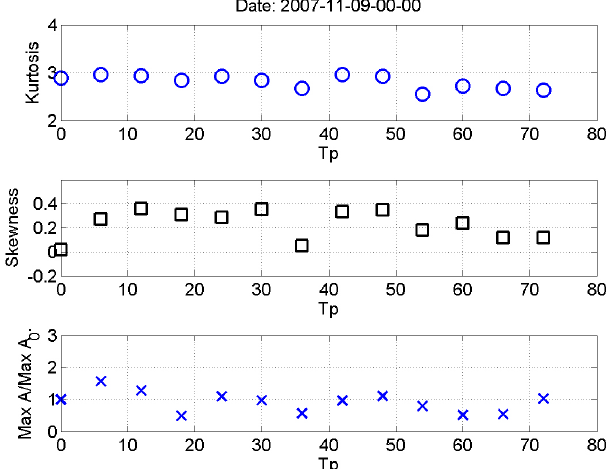
Figure 8. Temporal evolution of skewness, kurtosis and A max / A 0 ( A 0 denotes the initial amplitude used in the simulations while A max is the maximum amplitude (crest)), 9 November 2007, 00:00UTC.